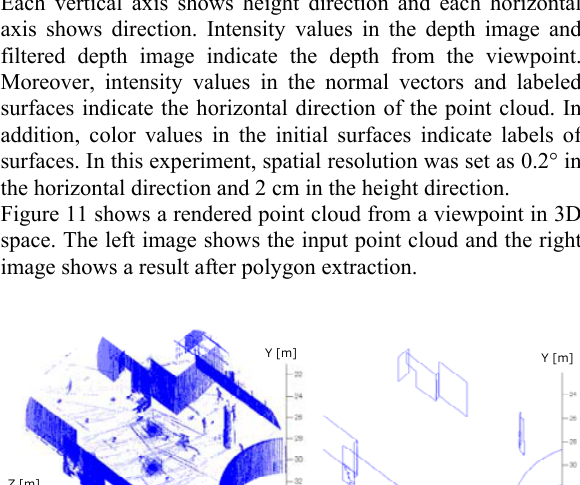
Figure 8. Acquired colored point cloud